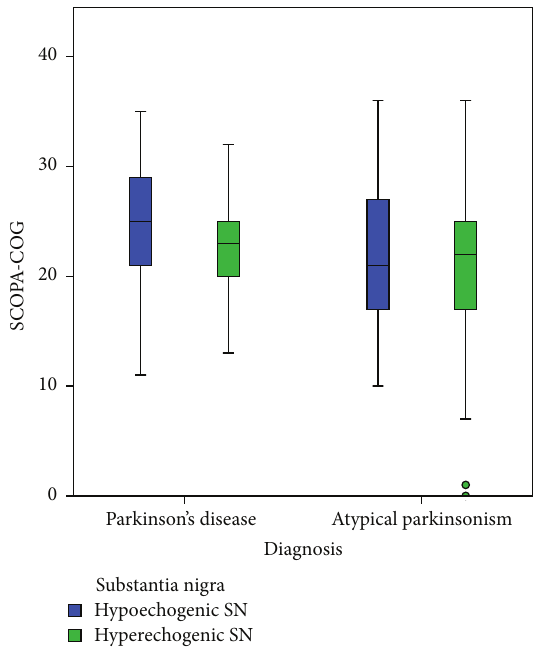
Figure 3: Boxplot of the range of scores on the SCOPA-COG scores compared to the echogenicity of the raphe